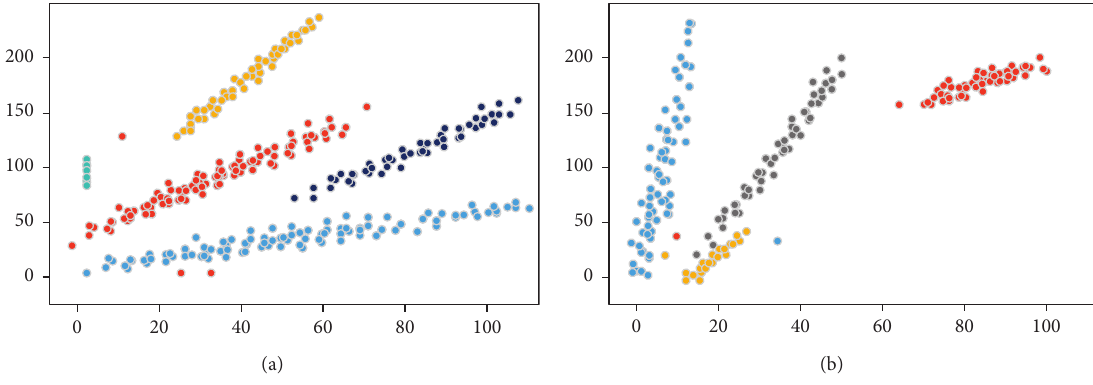
Figure 6: Characteristic distribution of sensor data.